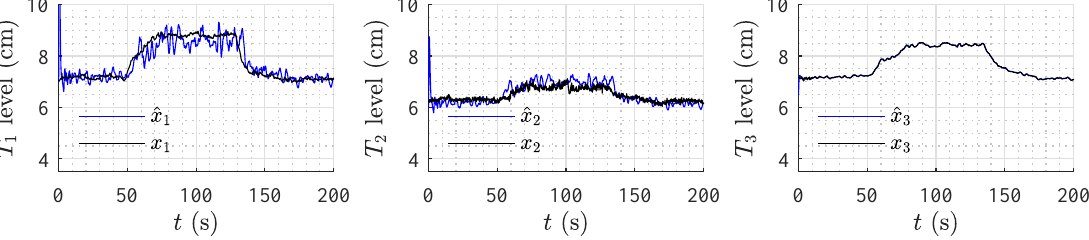
Figure 16. HGO estimation with unmeasured perturbation in Tank 1.